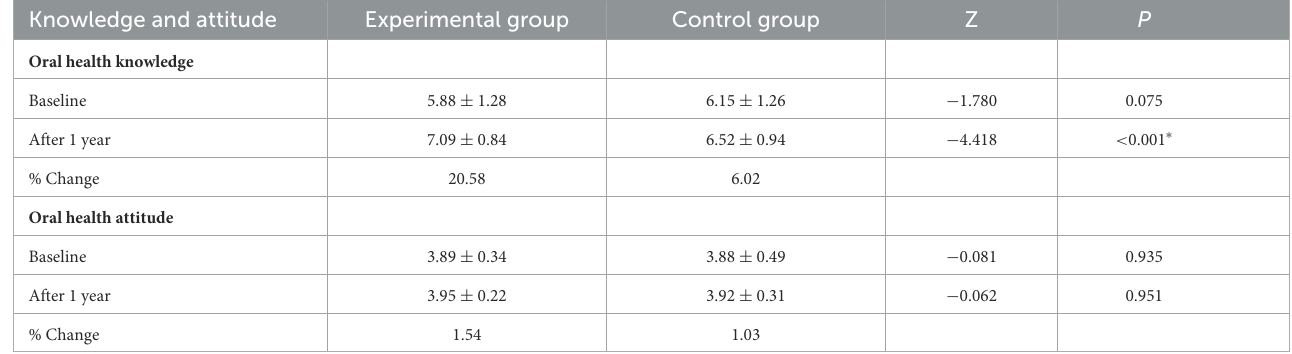
TABLE 7 Oral health knowledge and attitude in two groups at baseline and after a year (mean ± SD).